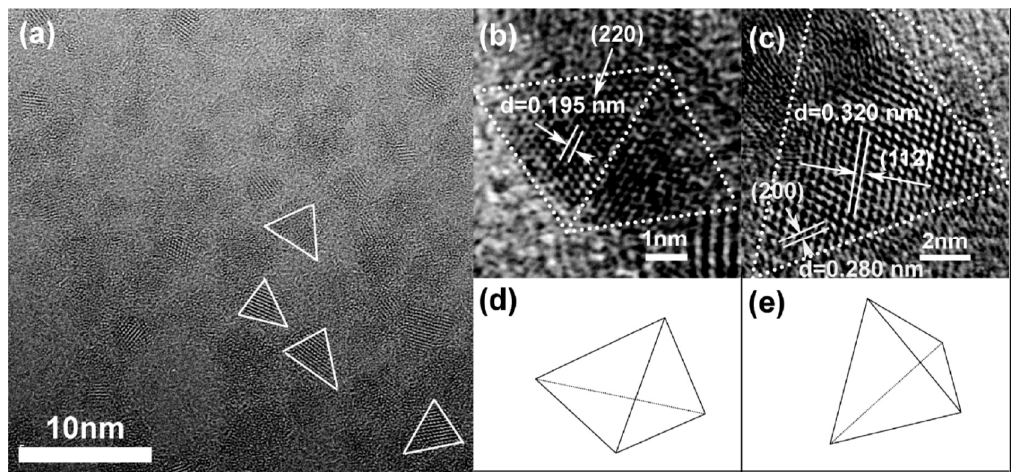
Figure 3. ( a ) High Resolution Transmission Electron Microscope (HRTEM) images of CIS QDs; ( b , c ) HRTEM images of a single CIS QDs; ( d , e ) schematic diagrams of CIS pyramids in b and c, respectively [20].